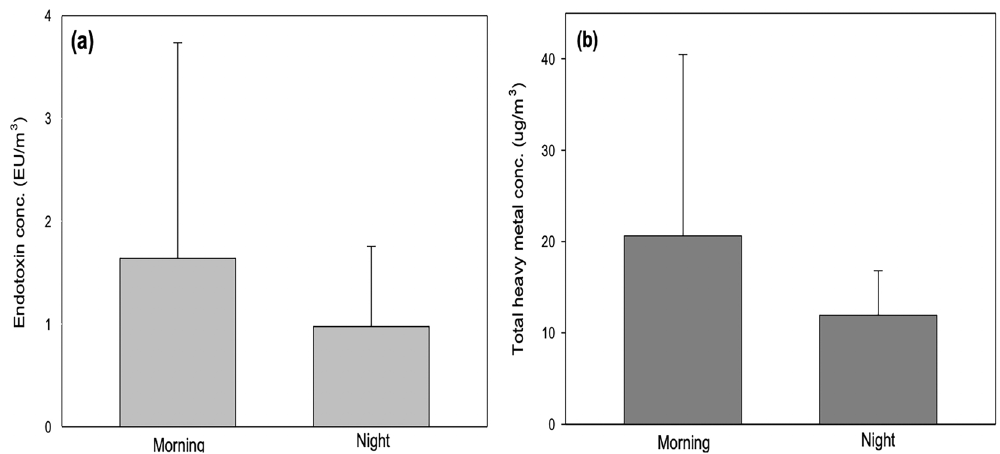
Figure 2. Morning and night variations in the levels of ( a ) endotoxin ( p > 0.05), ( b ) total heavy metals ( p >